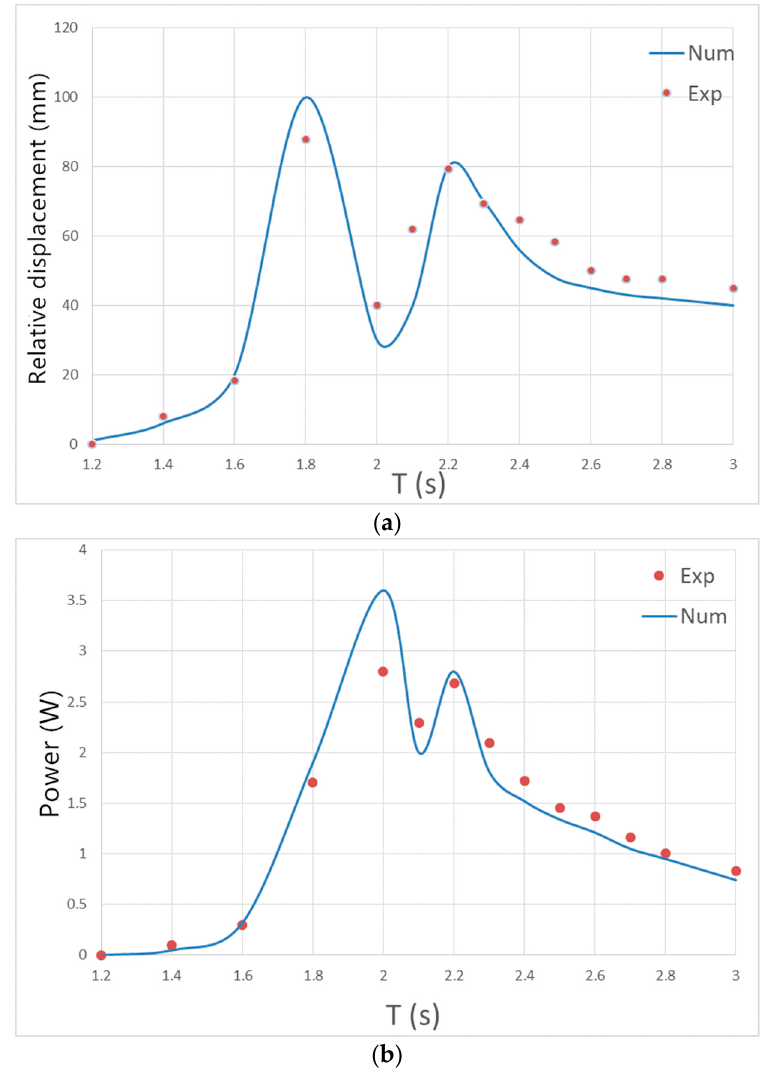
Figure 10. The motion and power comparison. ( a ) Relative displacement; ( b ) power output.